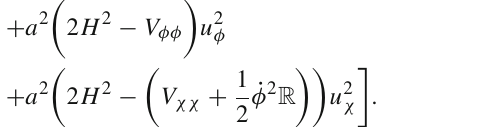
Fig. 2 Evolution of the mass of the spectator perturbation χ in Hub- ble units; from left to right for n = 1 , α = 10 − 3 , n = 1 , α = 10 − 4 , n = 1 . 5 , α = 10 − 3 , n = 1 . 5 , α = 10 − 4 ; the evolution of the Hessian